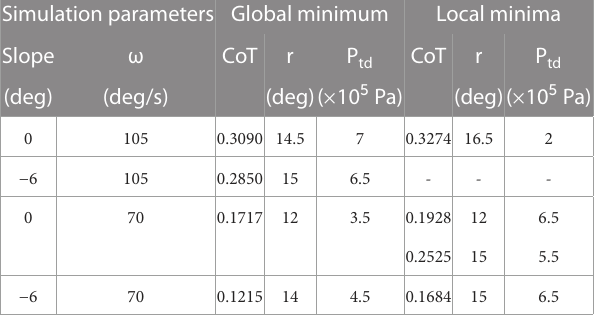
TABLE4 Experimentalsetups,andempiricallymeasuredvaluesand parametersoftheglobalandlocalminima. Simulation parameters Global minimum